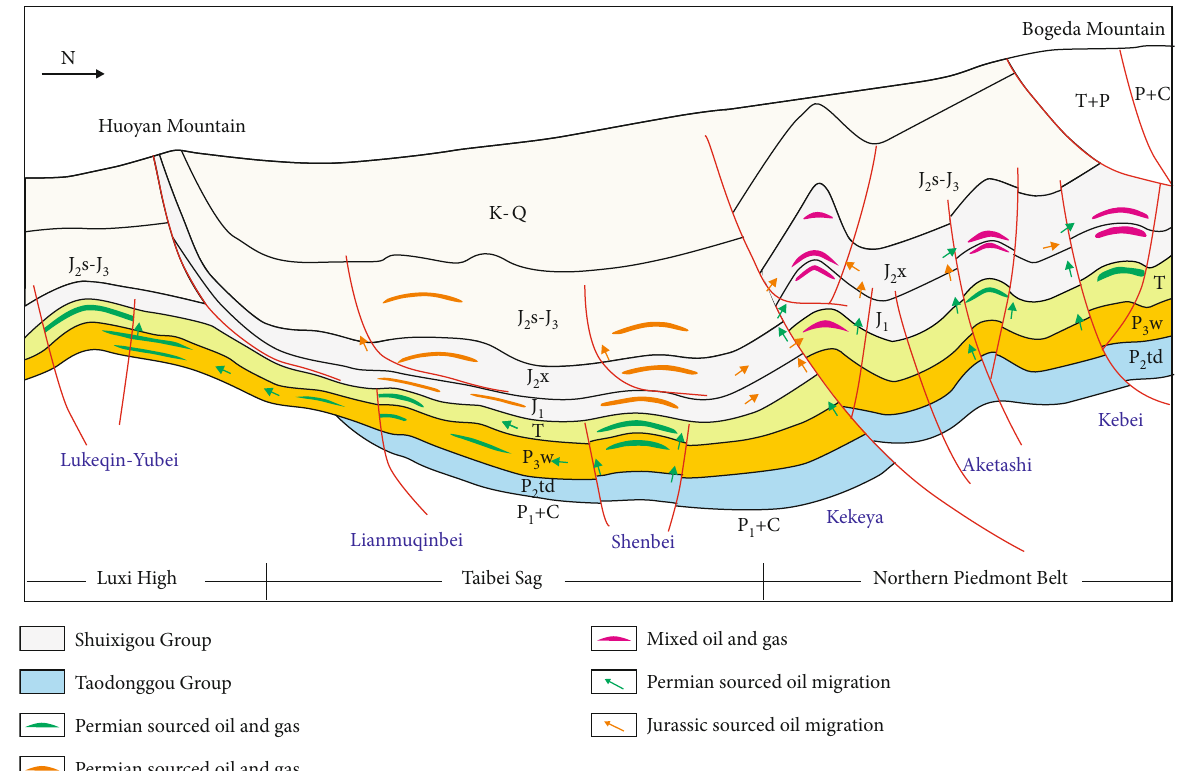
Figure 12: Hydrocarbon reservoir forming model in Turpan Sag, Turpan-Hami